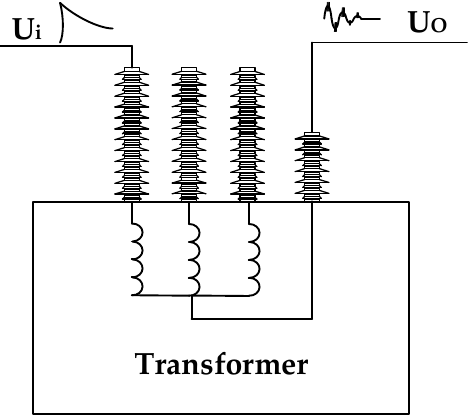
Figure 1. Detection schematic.